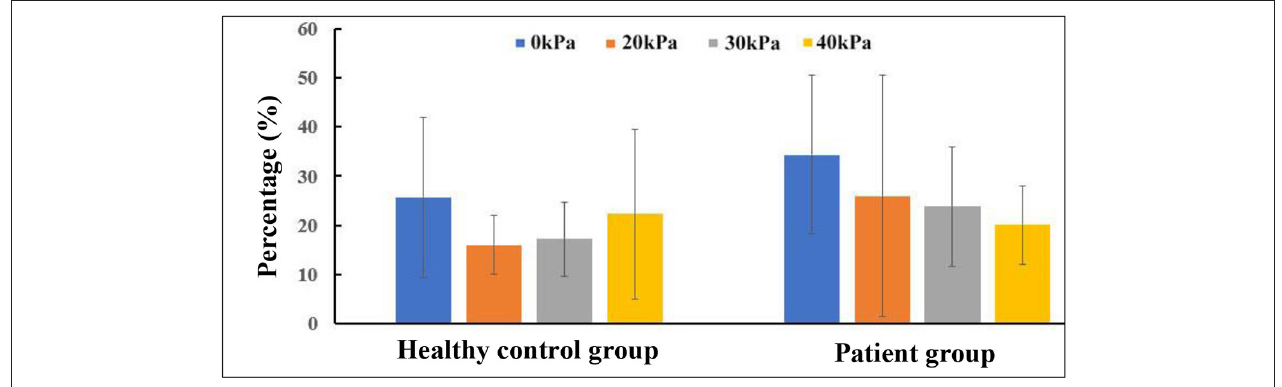
FIGURE 6 | Changes in percentage of low-averaged wall shear stress (AWSS) segments in carotid bifurcation.